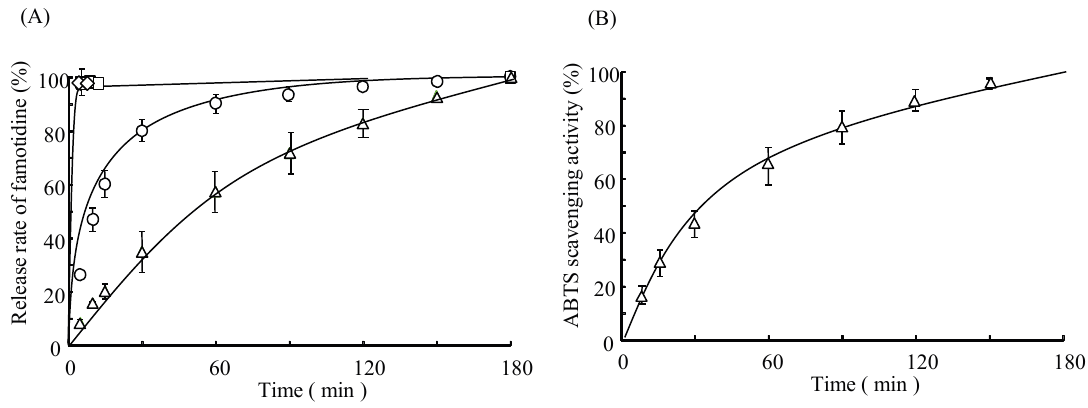
Figure 3. Release profiles of famotidine (FMT) from SDCH-NF/FMT or HA/FMT only, and SDCH-NF/HA/FMT tablet ( A ) and antioxidant activity of SDCH-NF/HA/FMT tablet ( B ) in distilled water. HA only ( ◊ ), UCH only ( □ ), SDCH-NF only ( ○ ), and SDCH-NF/HA ( ∆